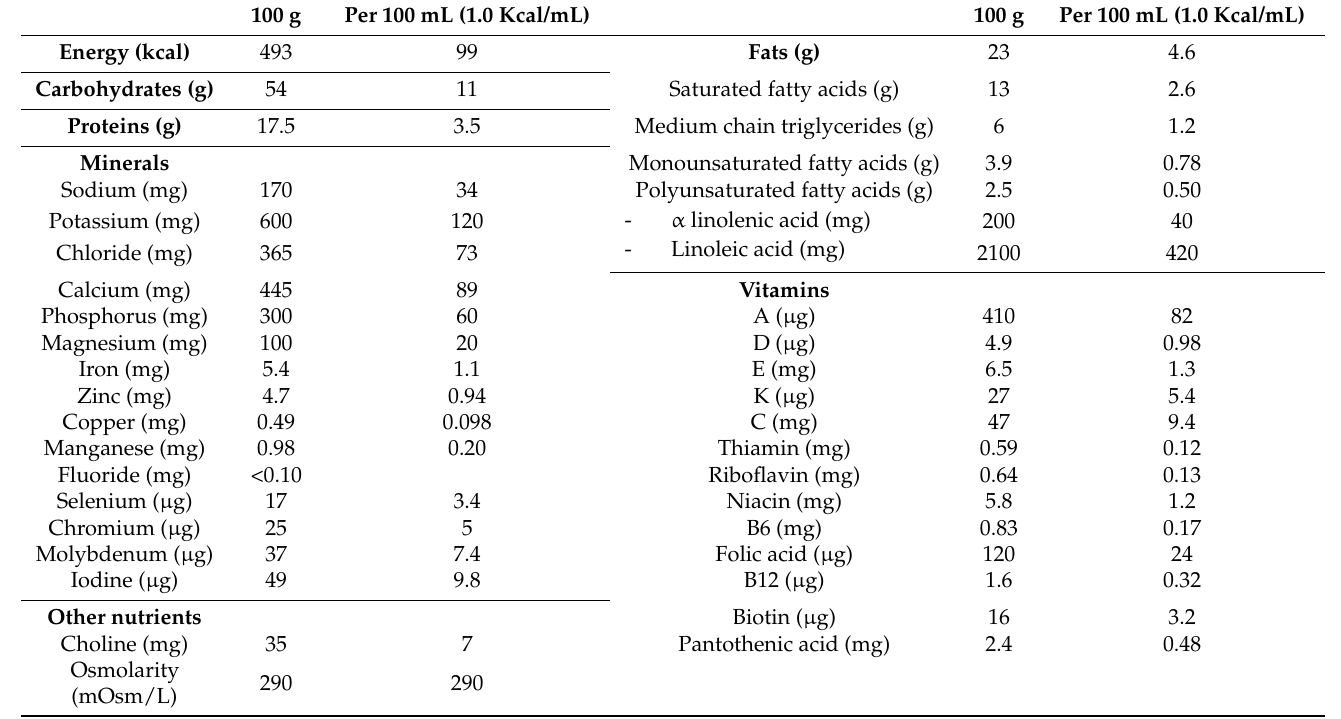
Table 2. Composition of Modulen IBD ®